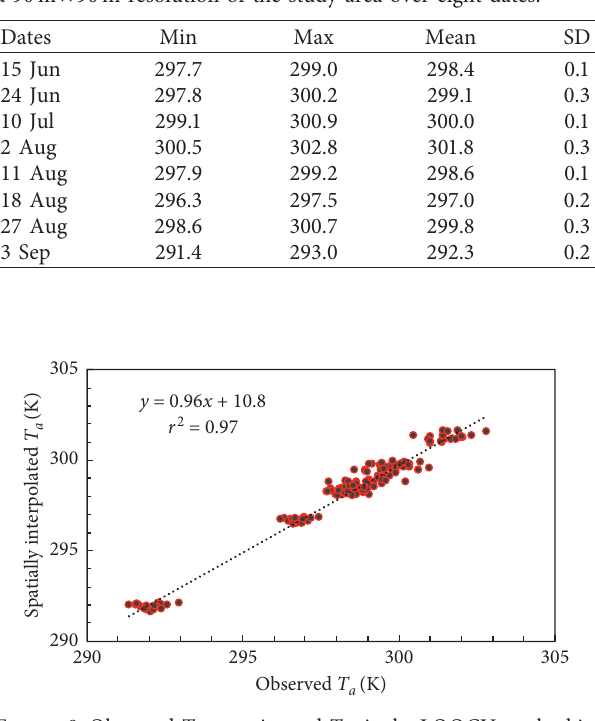
Figure 8: Observed T a vs. estimated T a via the LOOCV method in the study area over eight